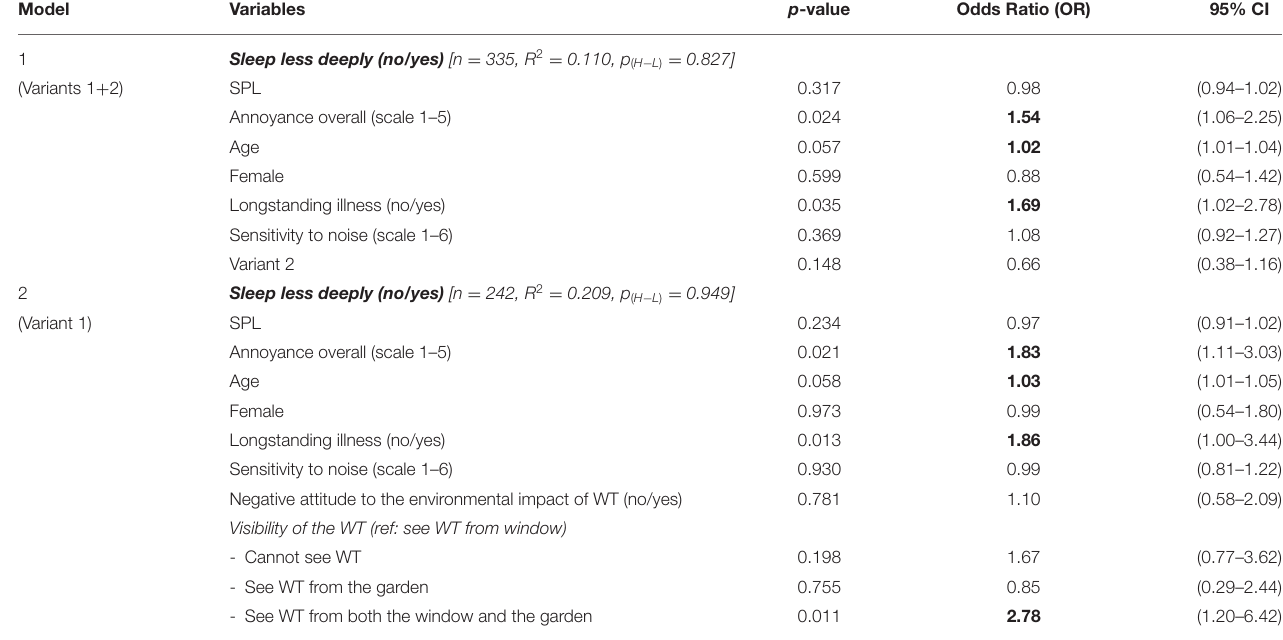
TABLE 3 | Association among sleep, WTN annoyance, and covariates.